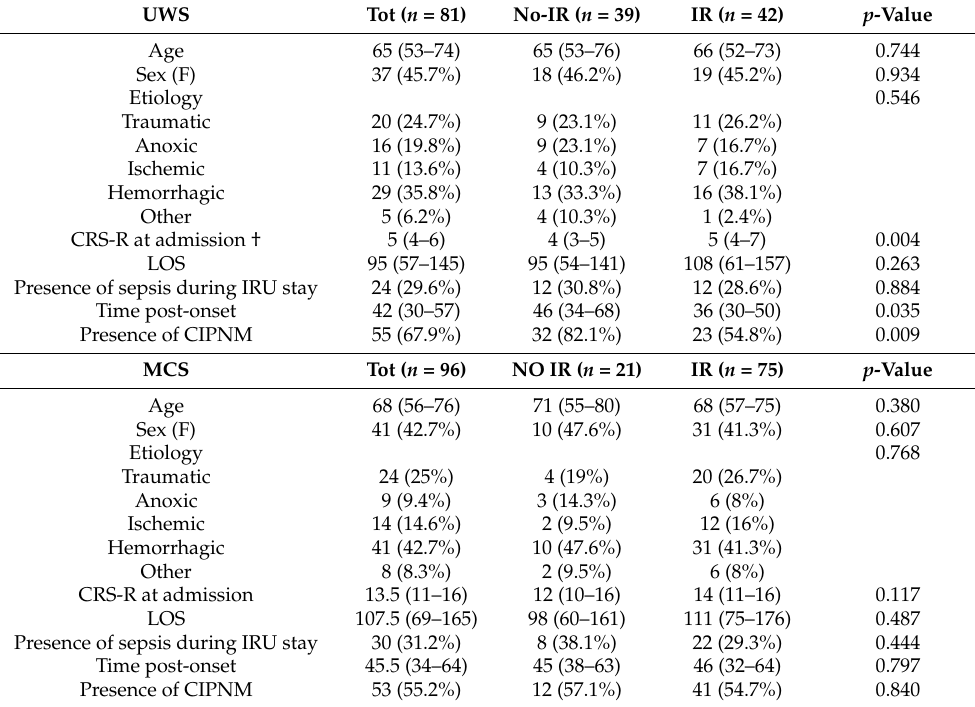
Table 3. Characteristics of patients belonging to the unresponsive wakefulness syndrome (UWS) and minimally conscious state (MCS) groups and comparison between those who did not improve responsiveness (No-IR) and those who improved responsiveness (IR) within the groups. UWS Tot ( n =